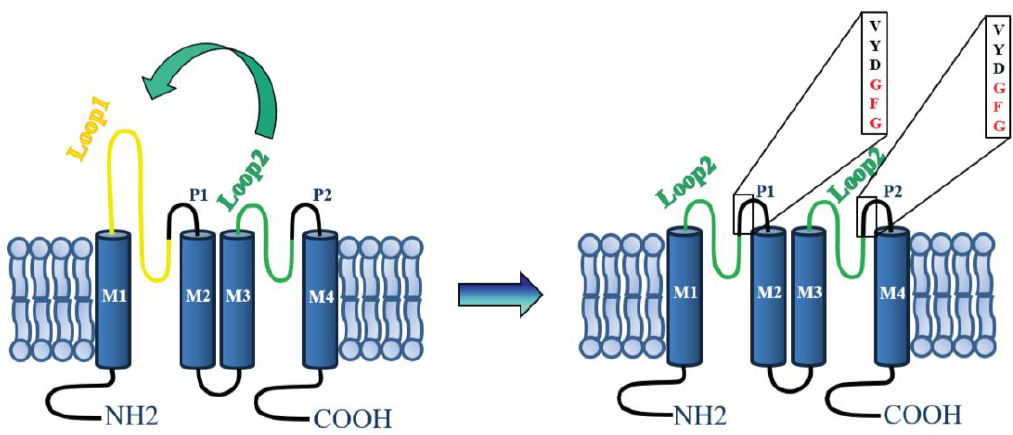
Figure 3. Schematic representation of the TASK-3 channel construct. A representation of the TASK-3 WT channel topological model is shown at the left. In this representation, each subunit has two pore-forming domains (P loops) and four transmembrane domains (denoted M1-M4). To the right is shown the TASK-3/2Loop2 channel construct with the amino acid sequence of selectivity filter illustrated in boxes.